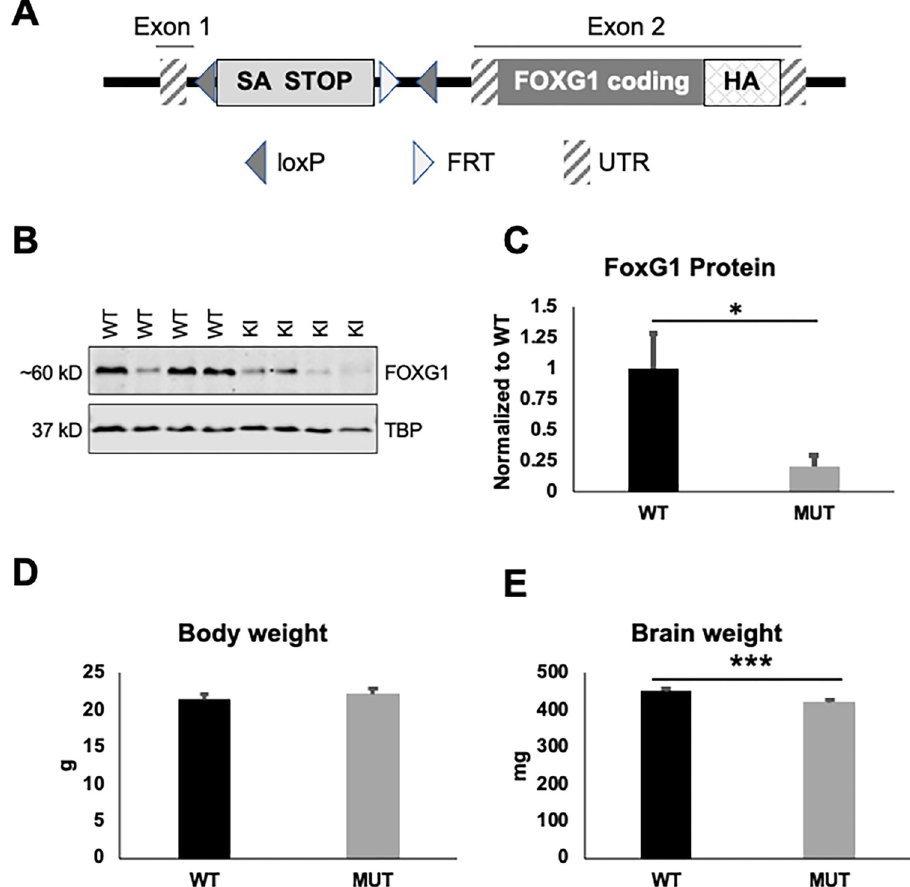
Fig 1. Generation of new allele of Foxg1 . A ) Design of the engineered allele of Foxg1 . Endogenous exons are indicated above. loxP sites are identified by left oriented triangle and FRT site by right facing triangle. Untranslated regions (UTR) are designated with diagonal stripes, endogenous coding sequence with dark grey, and inserted STOP cassette containing a splice acceptor (SA) designated in light grey. Three HA tags were inserted in-frame at the carboxy-terminus. B ) Western blot of FoxG1 protein in brains from heterozygous FoxG1 MUT/WT (MUT) animals compared to FoxG1 WT/WT (WT) animals. C ) Quantification of FoxG1 protein from WT and MUT animals, normalized to average WT protein amount. D) No difference in body weight between WT and MUT animals (F[1,27] = 1.977, p = 0.171). E) MUT animals have decreased brain weight compared to WT animals (F[1,31] = 22.339, p < 0.001). For panels D, E age = 16–17 weeks; Body weight: WT n = 15, MUT n = 15; Brain weight: WT n = 17, MUT n = 17. � p < 0.05, �� p < 0.01, ��� p <